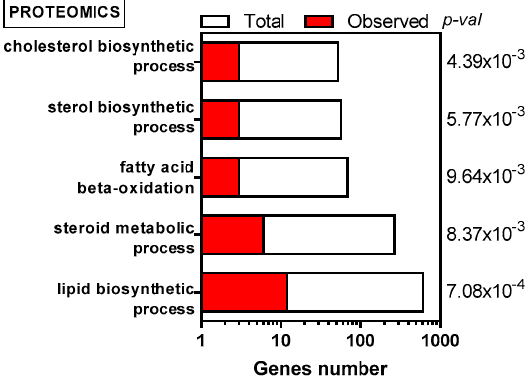
Figure 1. Enrichment in proteins associated with lipid metabolism in HL60 IDH1 R132H cells compared to WT cells ( n = 4), based on GO biological processes. (Total) means all the genes encoding the proteins corresponding to the pathways described in the literature while (observed) refers to the genes encoding the proteins found more abundant in IDH1 R132H cells.